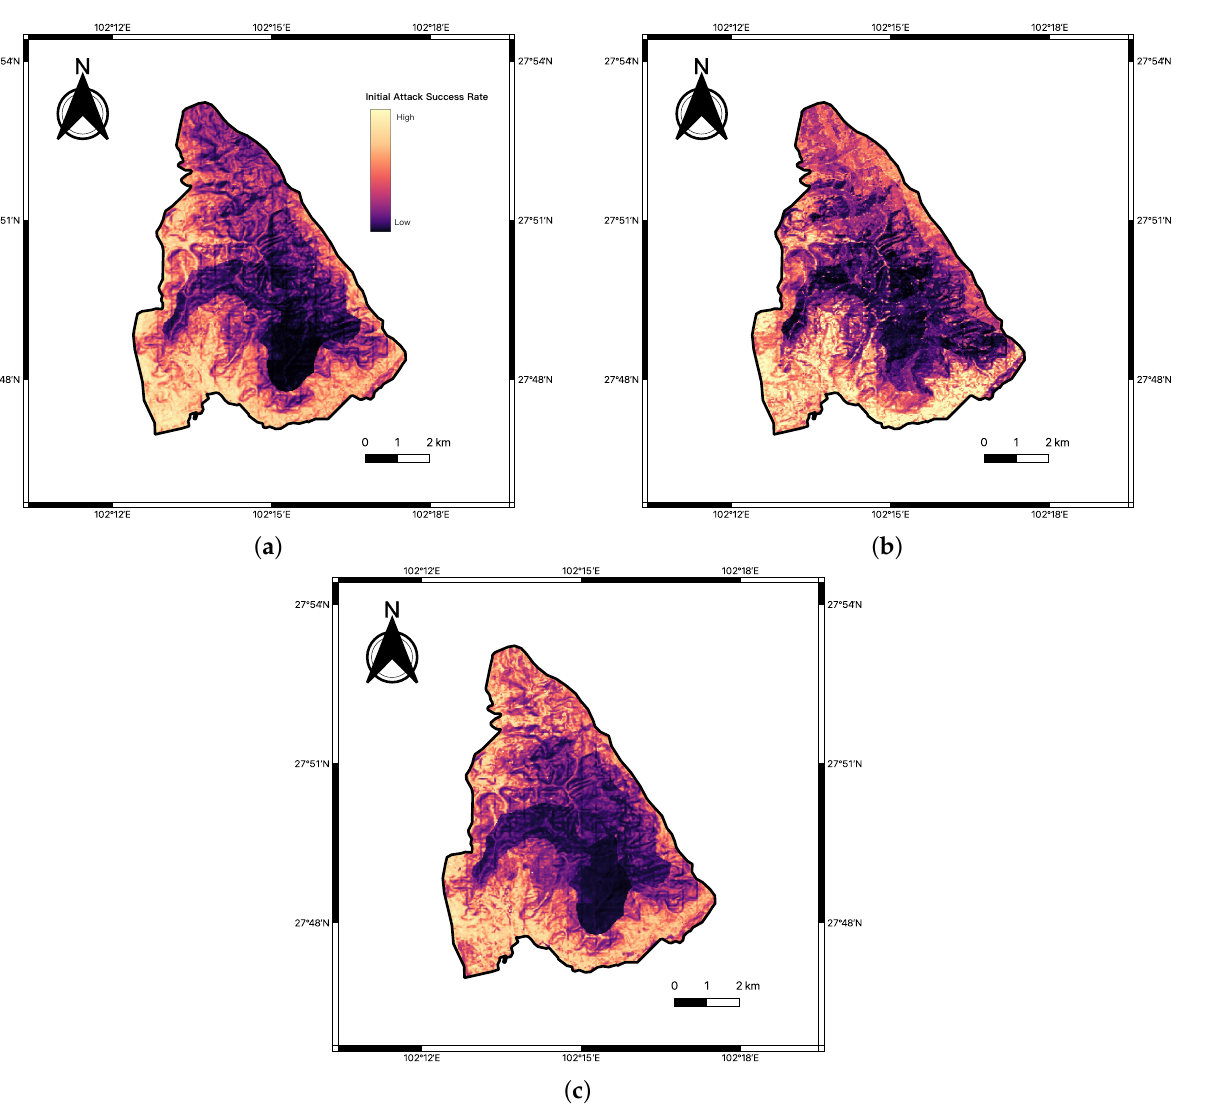
Figure 8. Simulated Initial Attack Results Under Normal Weather, low and high this correspond to a probability between 0 and 1; ( a ) Logistic Regression; ( b ) XGBoost; ( c ) Artificial Neural